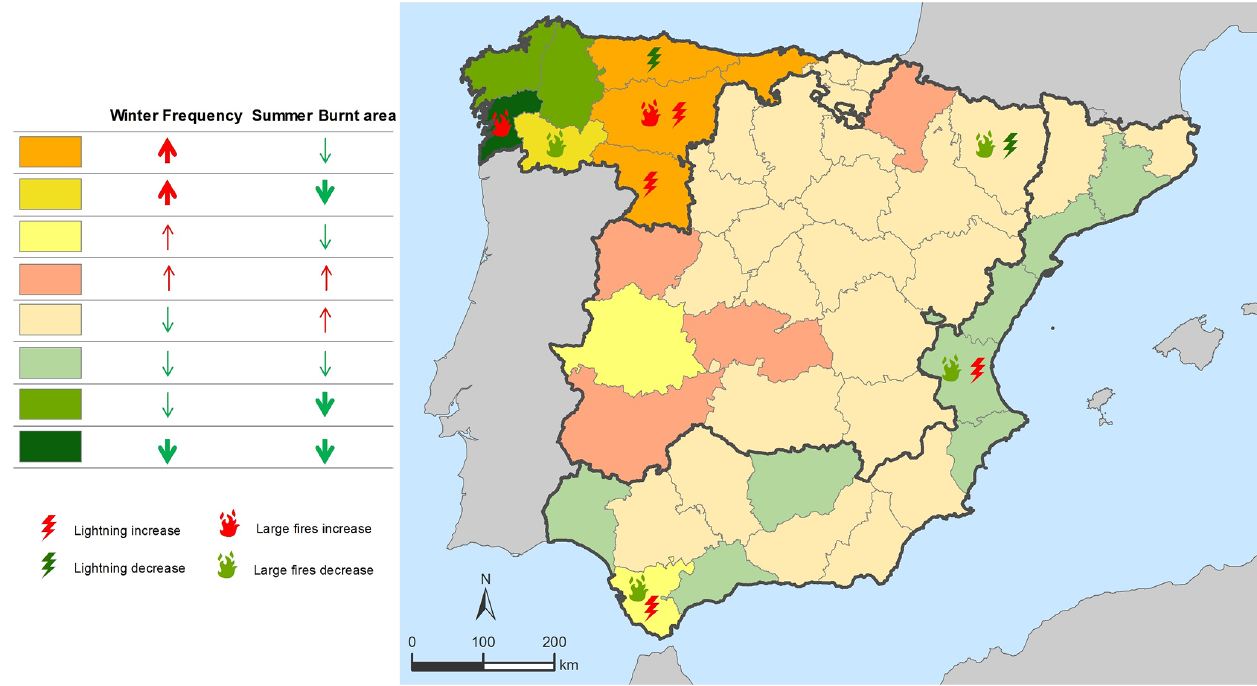
Figure 6. Summary of spatial–temporal behaviour from principal component analysis. Thick arrows mean significant trends, and thin ones are non-significant trends according to 90% confidence interval.